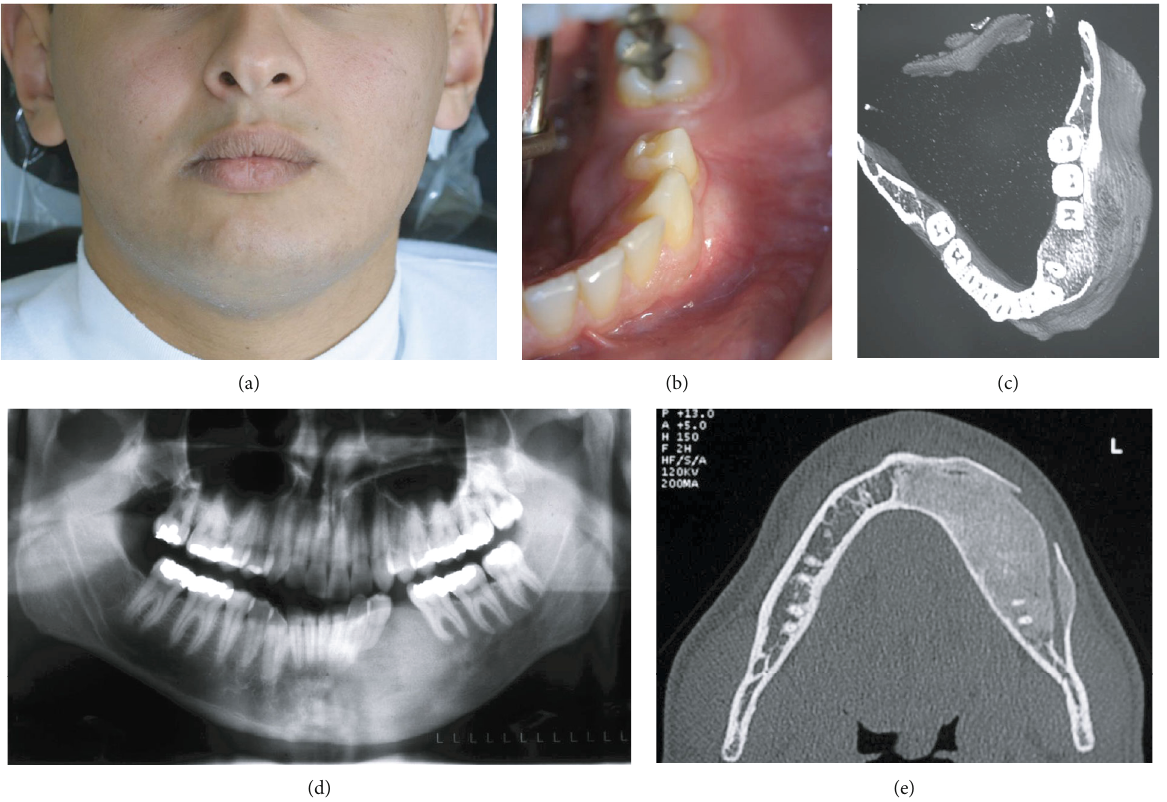
Figure 3: (a) Facial asymmetry at 10 years. (b) Clinical view of the intraoral swelling. (c) Panoramic X-ray at 10 years. (d) Axial image of a CBCT showing the expansion of the lesion to the midline and discontinuity of the buccal cortex. (e) 3D reconstruction showed an increase in the volume of the left hemimandible.